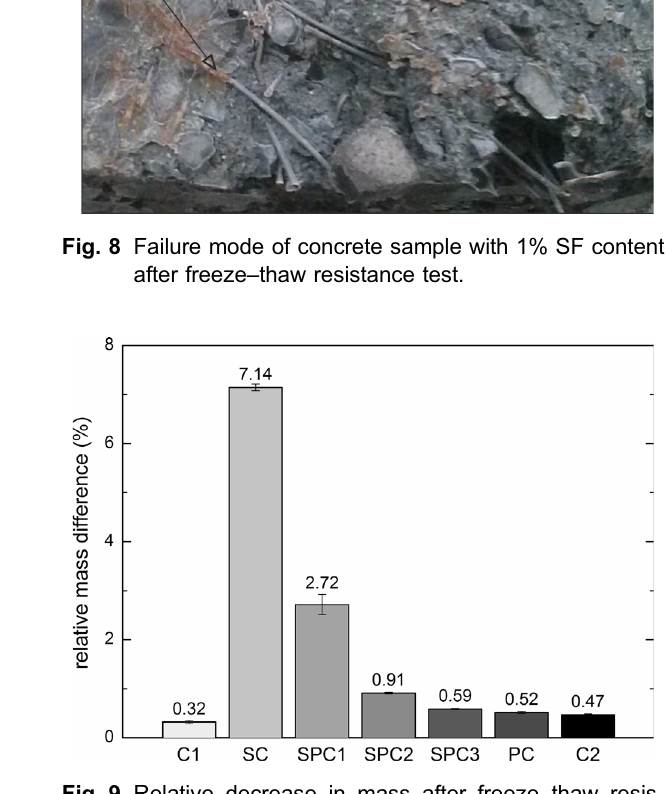
Fig. 9 Relative decrease in mass after freeze–thaw resis- tance